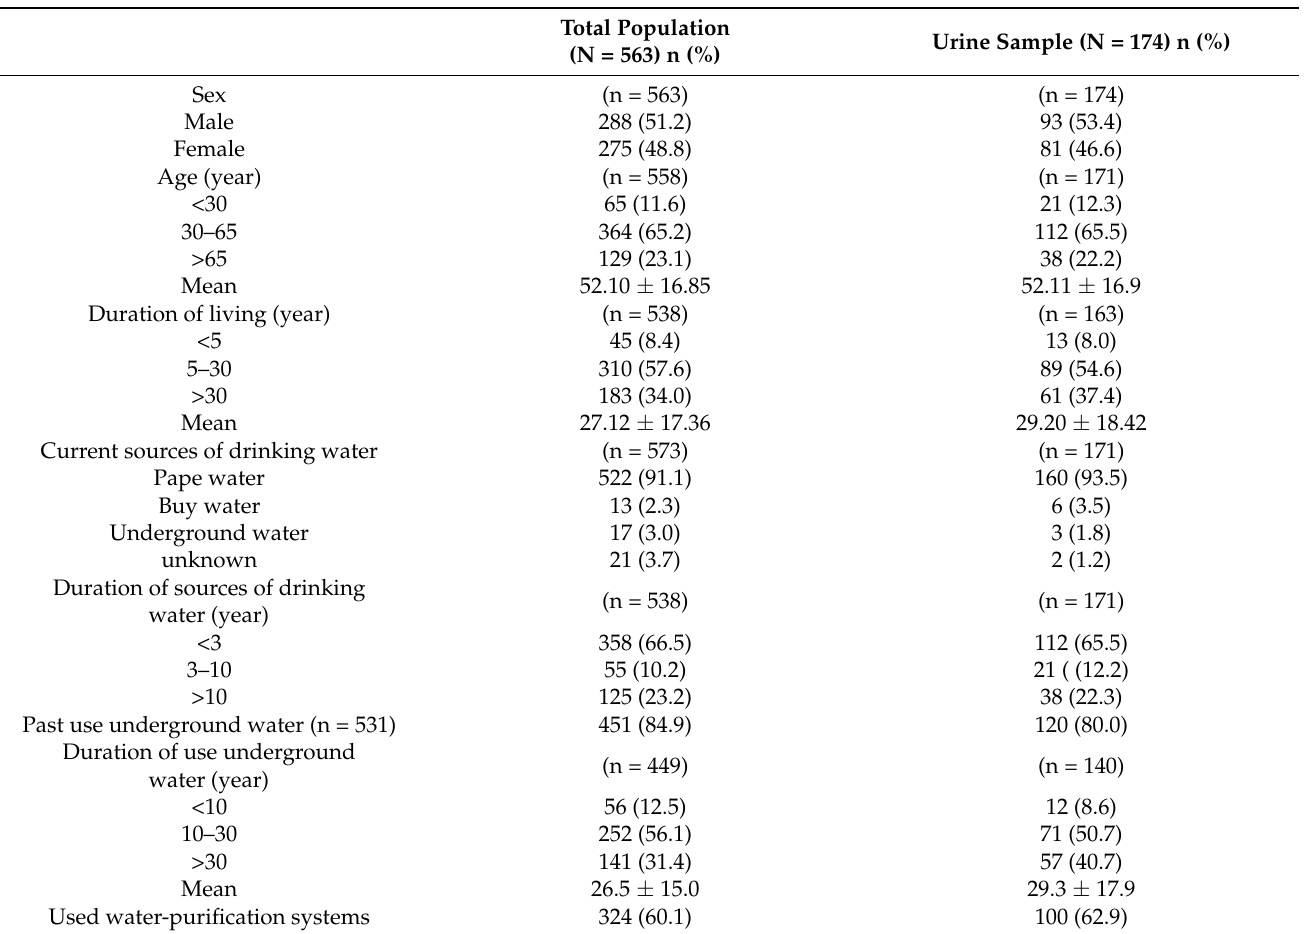
Table 1. Demographic information and information regarding the use of underground water obtained using a questionnaire in the total population and urine samples.